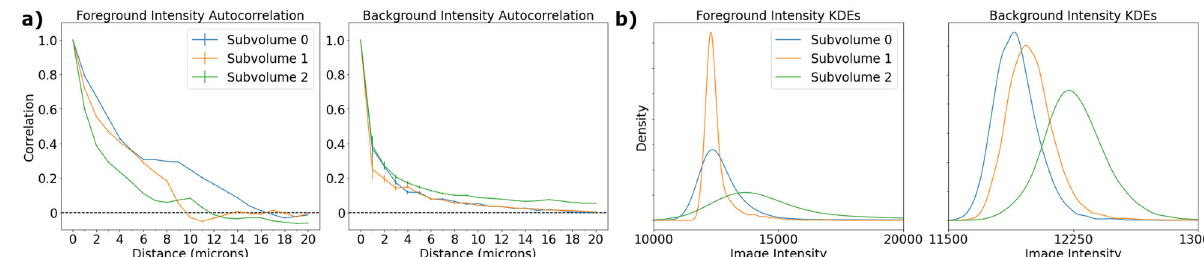
Fig. 3 Characterization of voxel intensity distributions in three different subvolumes of one of the Mouselight whole-brain images. a Correlation of intensities between voxels at varying distances from each other. The curves show that intensities are only weakly correlated ( ρ < 0.4) at a distance of > 10 microns for foreground voxels, or a distance of > 2 microns for background voxels. Error bars represent a single standard deviation of the Fisher z-transformation of the correlation coef fi cient. Each curve was generated from all pairs of 5000 randomly sampled voxels. b Kernel density estimates (KDEs) of foreground and background intensity distributions. A subset of the voxels in each subvolume was manually labeled, then used to train an Ilastik model to classify the remaining voxels. Each KDE was generated from 5000 voxels, according to the Ilastik classi fi cations. KDEs were computed using scipy ’ s Gaussian KDE function with default parameters 38 .